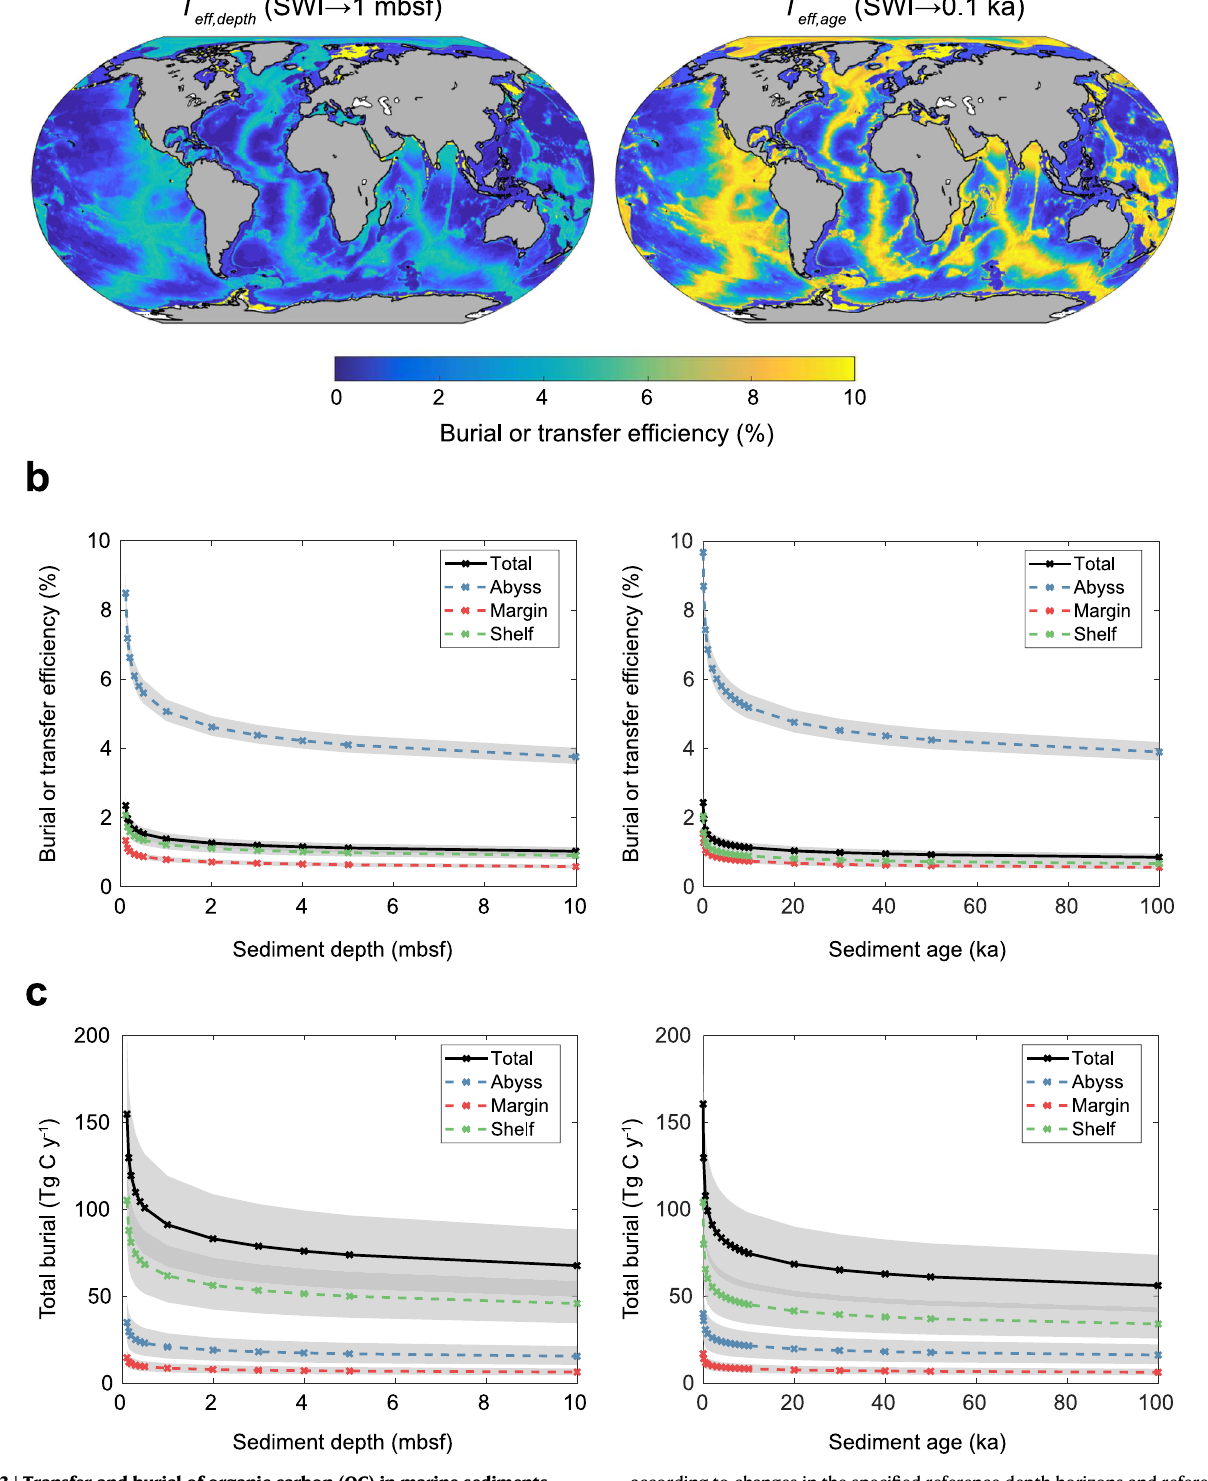
according to changes in the speci fi ed reference depth horizons and reference age horizons. c Total OC buried beyond speci fi ed sediment depths and ages. Gray shading in ( b ) and ( c ) represent uncertainty envelopes (±10% in φ and ω , see Supplementary